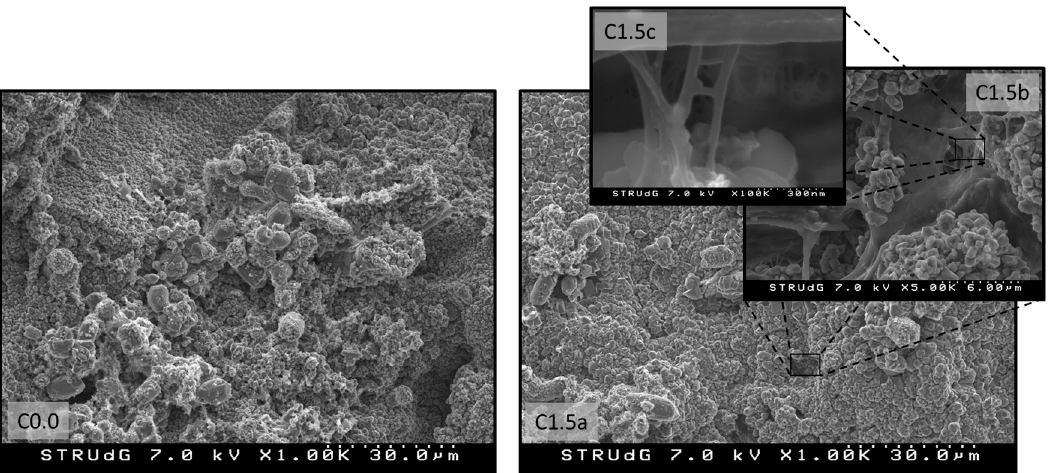
Figure 5. FE-SEM micrographs of (C0.0) neat cement and (C1.5) reinforced cement with 1.5 wt% of LCMNF.